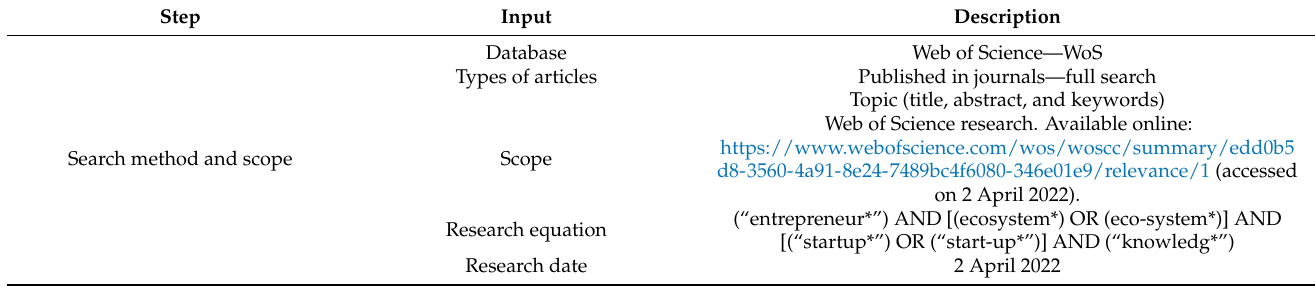
Table 1. Systematic literature review